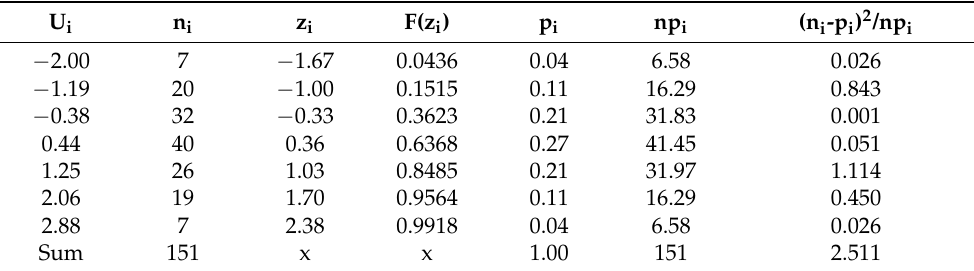
Table 3. Statistical data for the χ 2 Pearson